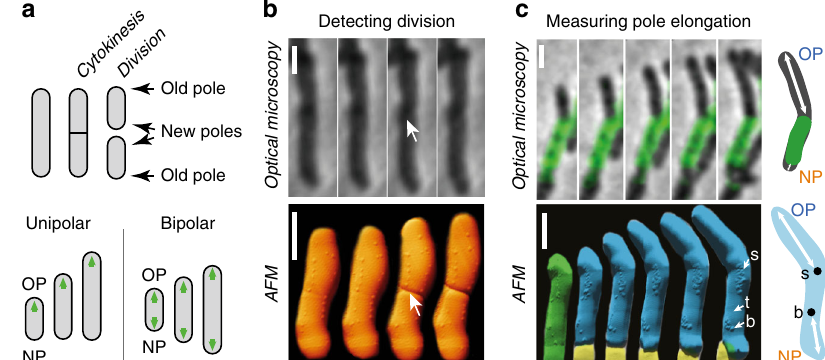
Fig. 1 Measurement of M. smegmatis pole elongation dynamics using AFM. a Schematic of unipolar 8 and bipolar 7 elongation models. OP, old pole. NP, new pole. b Comparison between phase-contrast and AFM time-lapse images of dividing cells measured on different instruments. Arrows indicate the division site in the fi rst frame following the division event. For phase-contrast microscopy data, the division event was detected using the method described in Supplementary Fig. 5. Scale bar, 1 μ m. Time between consecutive images is 10 min for phase-contrast microscopy data and 13 min on average for AFM data. c Absolute measurement of pole elongation using fl uorescence pulse-chase labeling and AFM-resolved surface nanostructures as fi ducial markers. Scale bar, 1 μ m. Top: combined phase-contrast and fl uorescence images of an elongating cell. Time between consecutive images is 30 min. The schematic illustrates how fl uorescently labeled cell wall (green) can be used as a fi ducial marker to measure pole elongation (white arrows). Bottom: AFM time-lapse images of a mother cell (green) and its two daughter cells (blue and yellow). Surface nanostructures used as fi ducial markers are indicated with a white arrow: division scar (s), protruding bleb (b), trough (t). The schematic illustrates how surface nanostructures ( ● ) are used as fi ducial markers to measure pole elongation over time. Time between two images is 1.25 h on